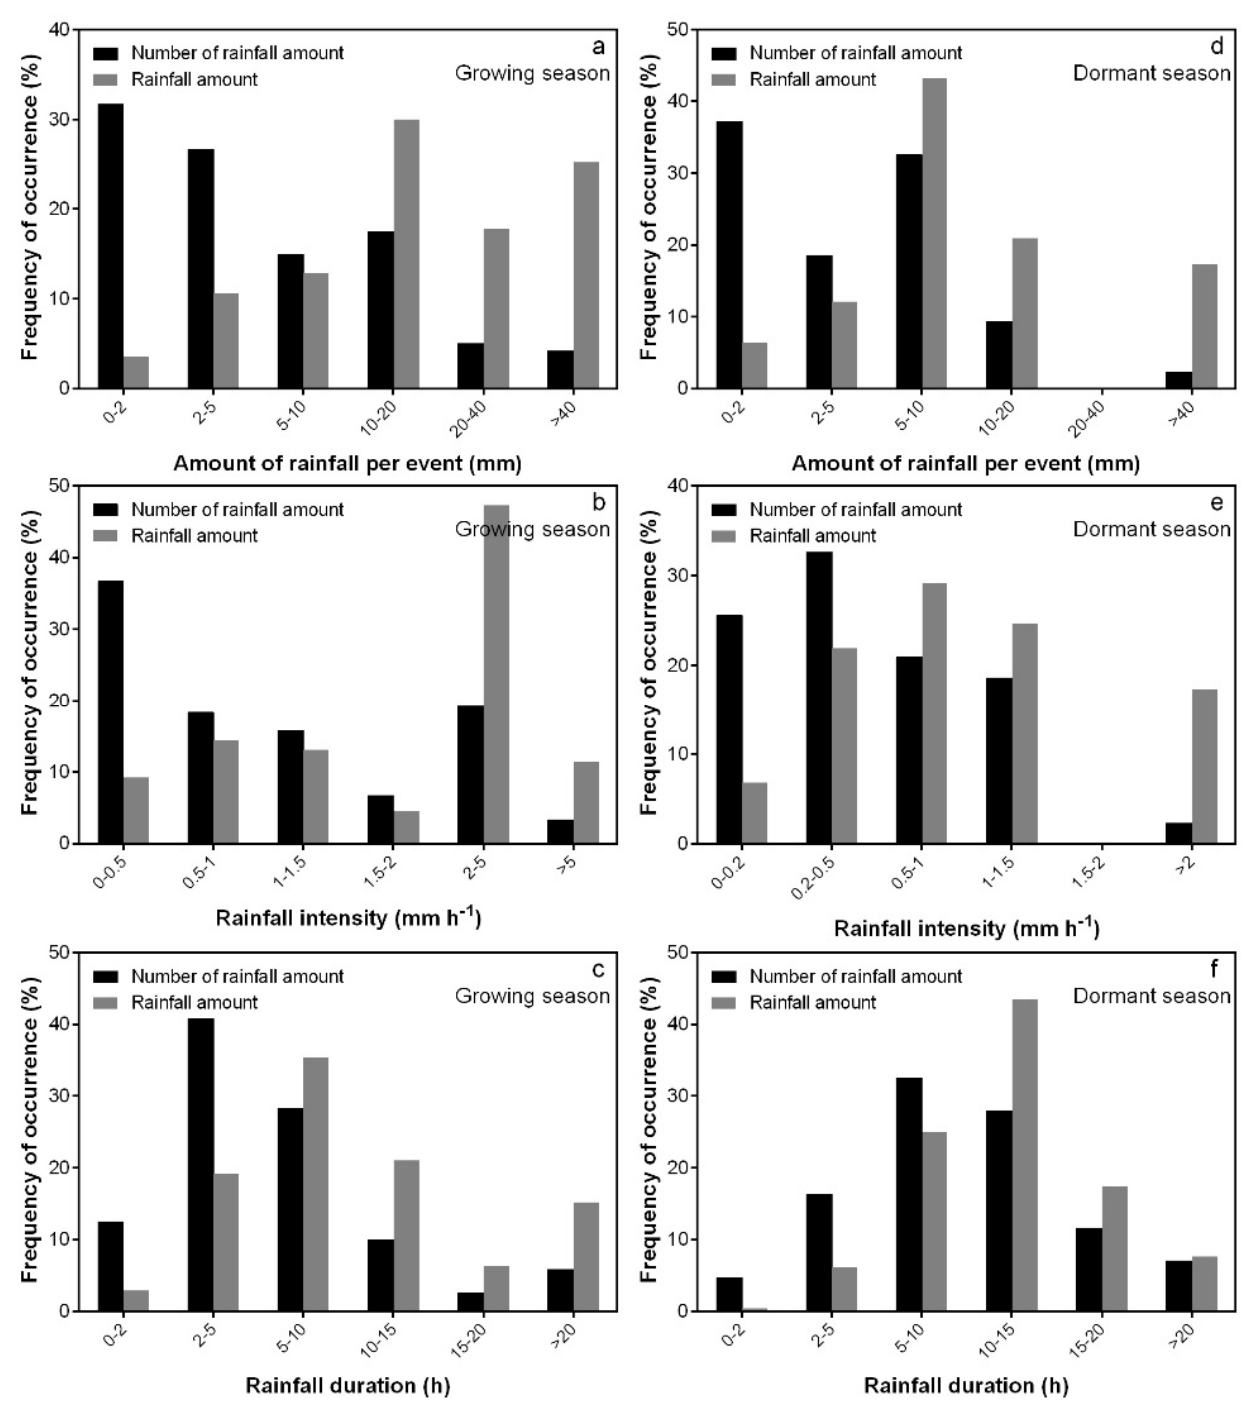
Figure 1. The frequency distribution of rainfall events in 2015 and 2016, along with the amount of rainfall depth and events in different ranges of event size ( a , d ), intensity ( b , e ) and duration ( c , f ).